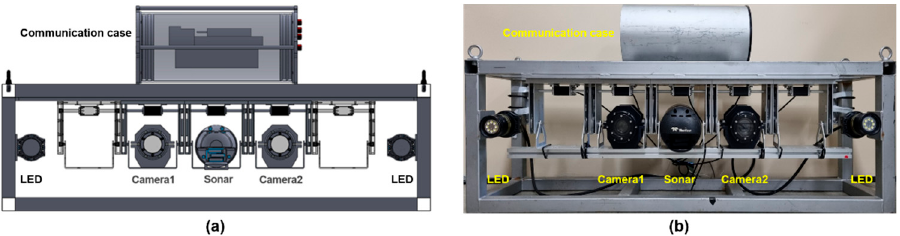
Figure 2. Optical-sonar fusion system, ( a ) schematic design and ( b ) real hardware comprising two underwater cameras and one multi-beam sonar.